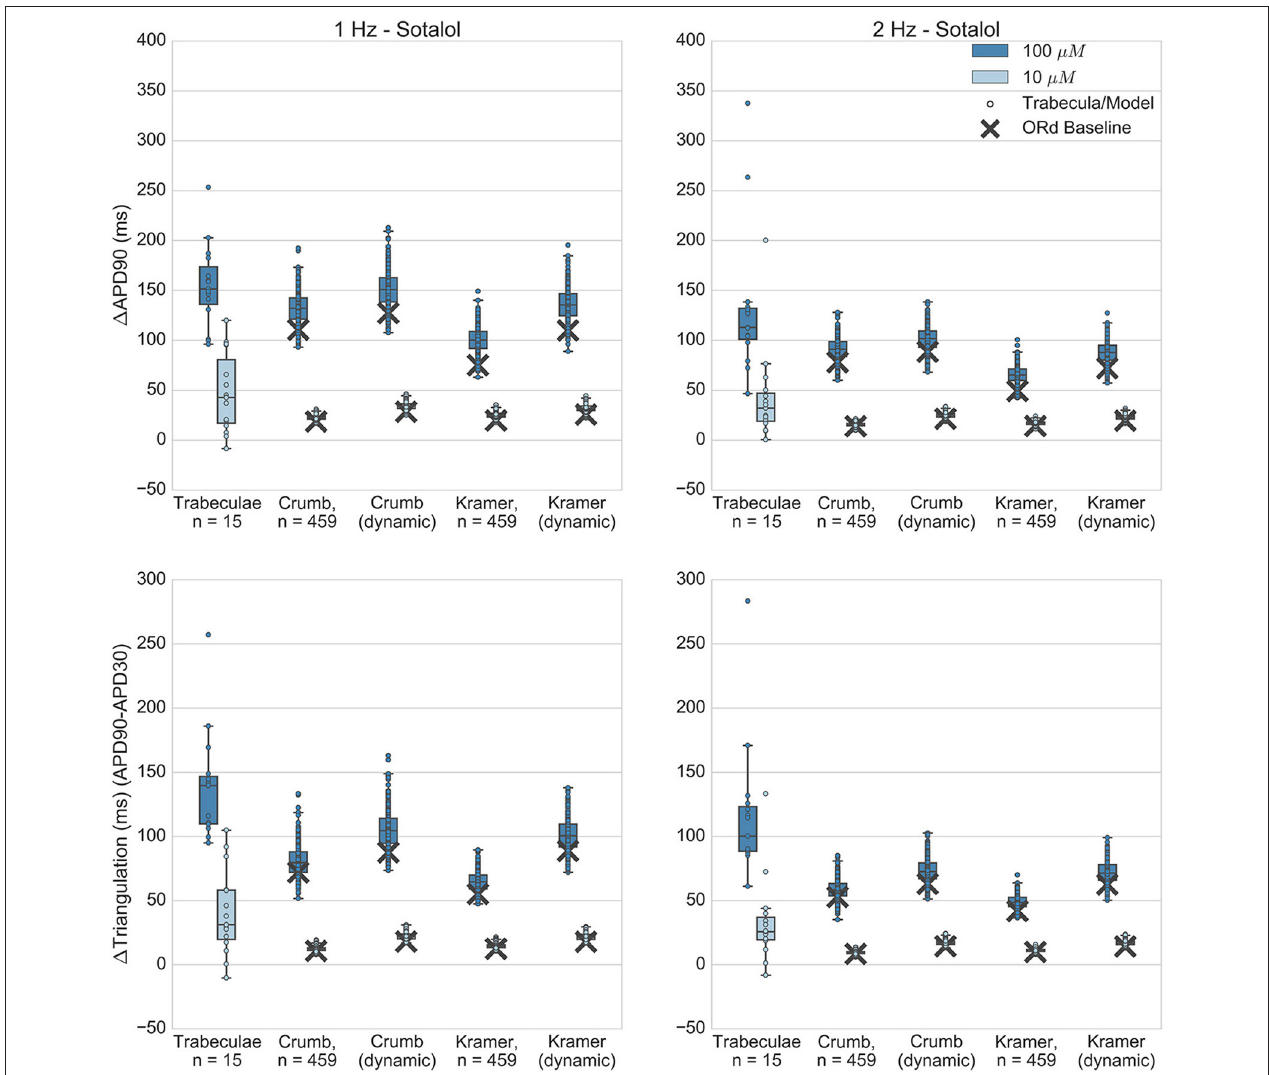
FIGURE 6 | Sotalol. Changes to APD90 and triangulation relative to control from application of 10 and 100 µ M sotalol during 1 and 2 Hz pacing. In each panel, response is shown for (left to right): human ventricular trabeculae, populations of models using drug effects calculated using data from Crumb et al. from Crumb et al. with I Kr replaced by the Li et al. I Kr model; from Kramer et al. and from Kramer et al. with I Kr replaced by the Li et al. I Kr model. Dots indicate results from individual trabeculae and models, crosses show the result from the baseline ORd